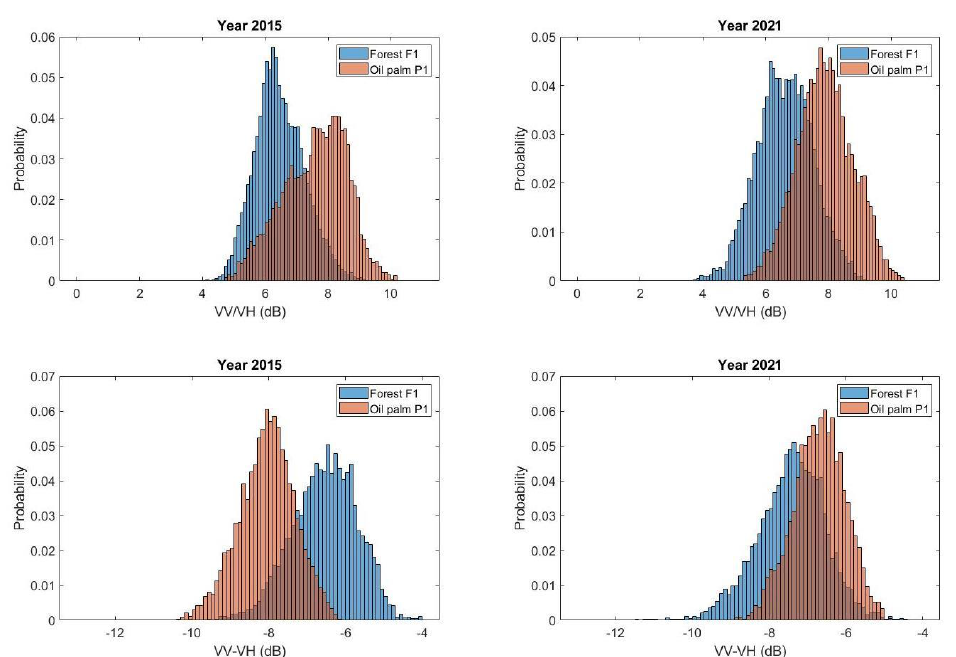
Figure 16. Histograms of VV/VH ratio and VV–VH difference both expressed in dB for 2015 and 2021 acquisitions and F1 and P1 polygons during the wet season.